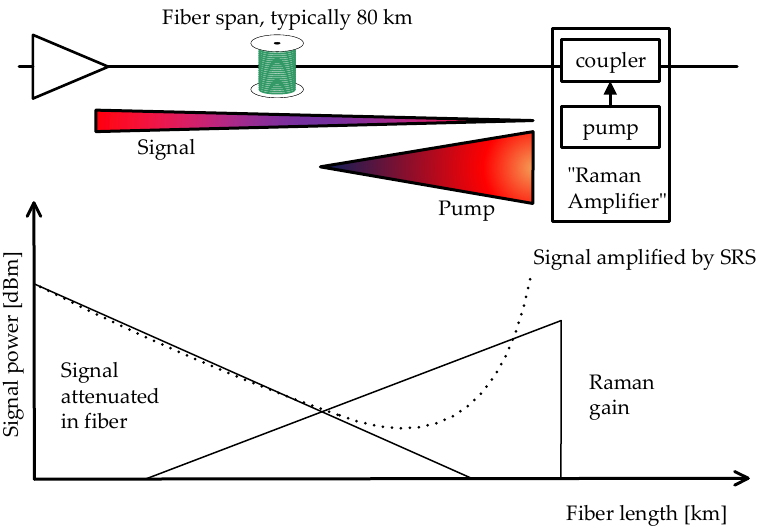
Figure 12. Schematic diagram of backward Raman amplification (counterdirectional